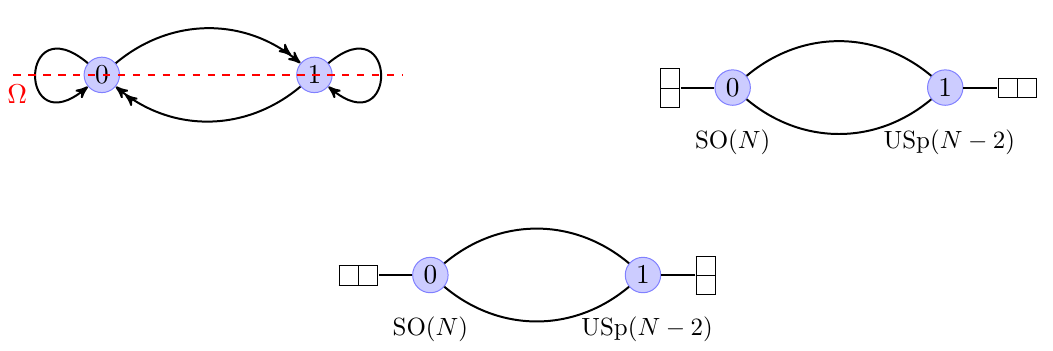
Figure 5. The quiver diagram for C 2 / Z 2 × C with the orientifold projection Ω on the top left, while on the top right the associated (linear) ‘unoriented’ quiver after the N = 2 choice for the orientifold and the N = 1 choice at the